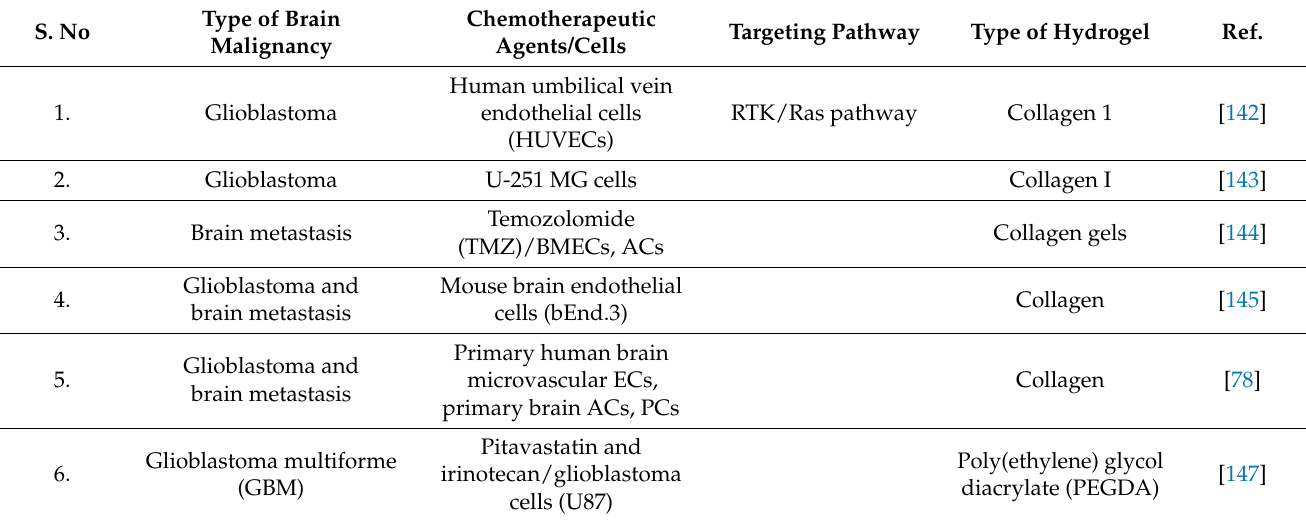
Table 2. Overview of hydrogel-based BBB models for brain